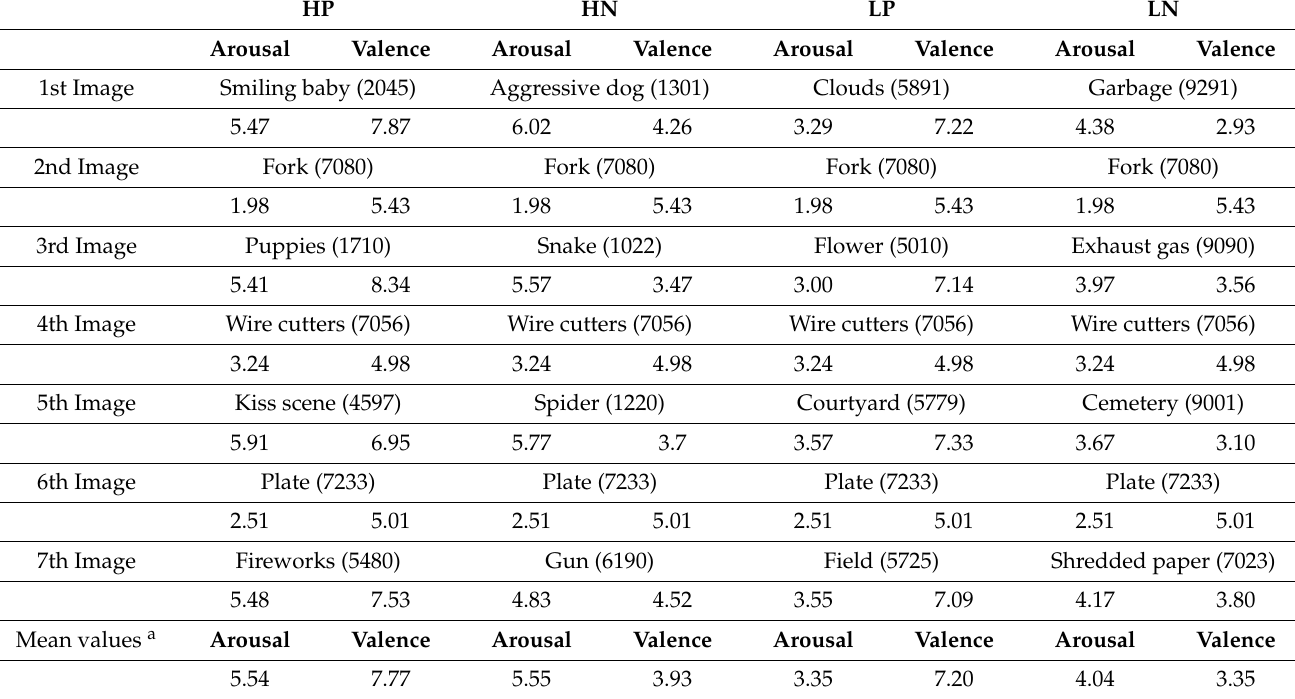
Table 2. Images chosen for the experiment. The table reports the images chosen for the HP (high arousal positive valence), HN (high arousal negative valence), LP (low arousal positive valence), and LN (low arousal negative valence). Arousal and valence values for each image are those provided in the IAPS Inventory [51]. Each image is specified by the IAPS code in